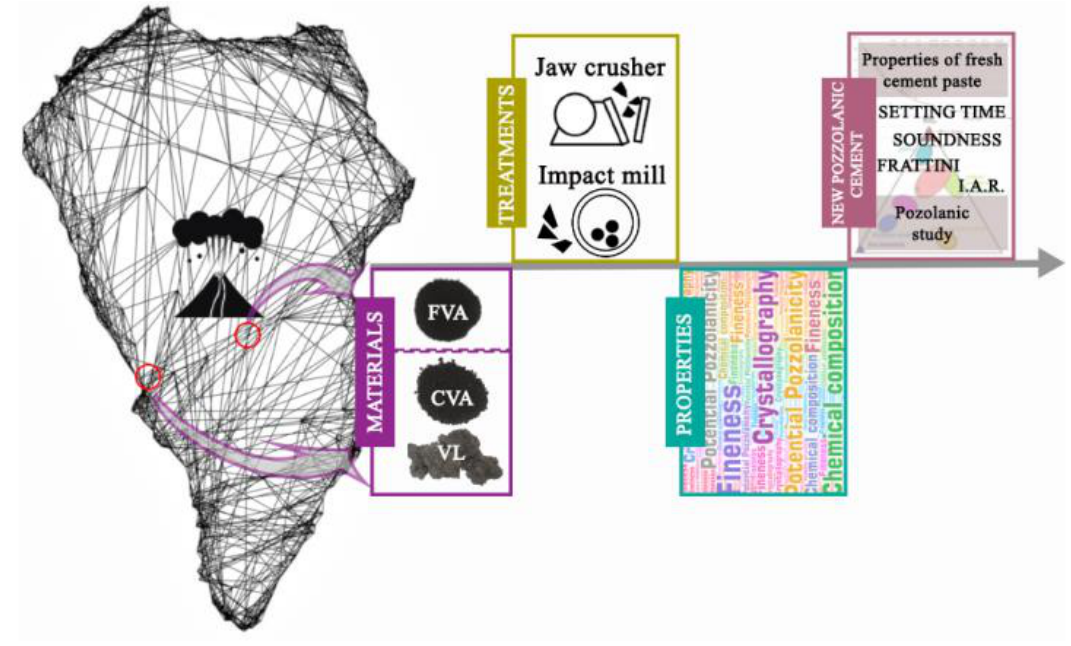
Figure 1. Experimental scheme.